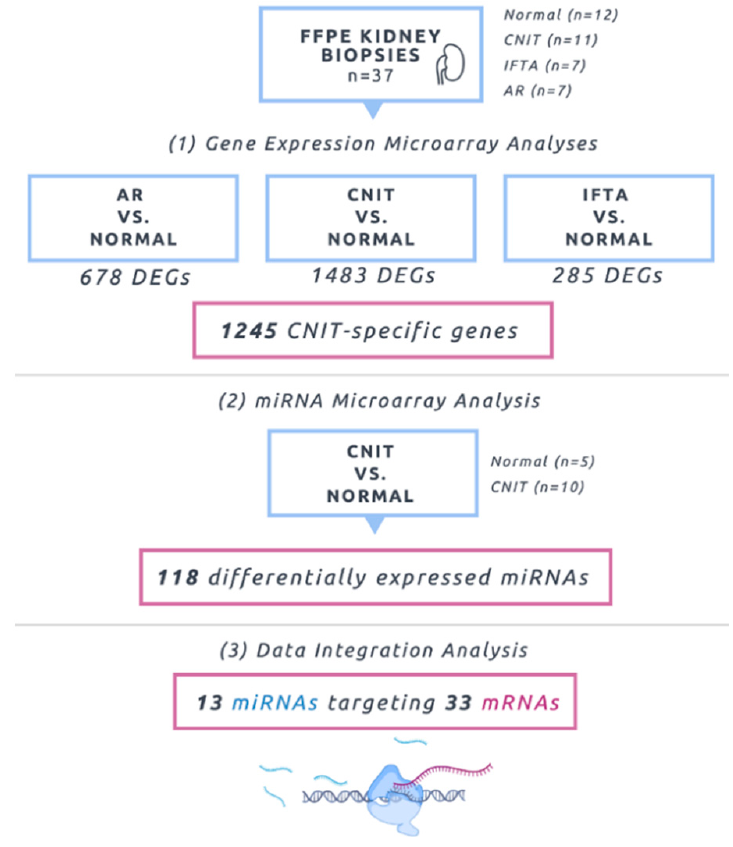
Figure 1. Gene expression microarrays of 37 formalin-fixed paraffin-embedded (FFPE) kidney